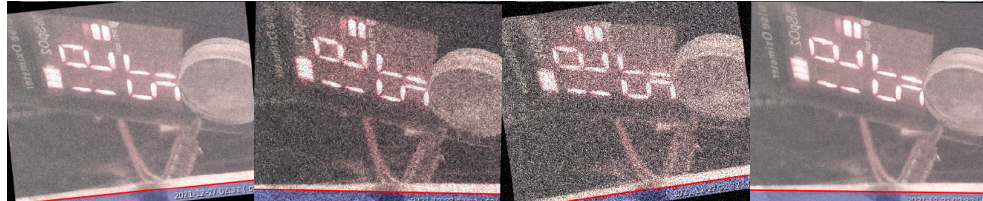
Figure 5. Samples generated using image